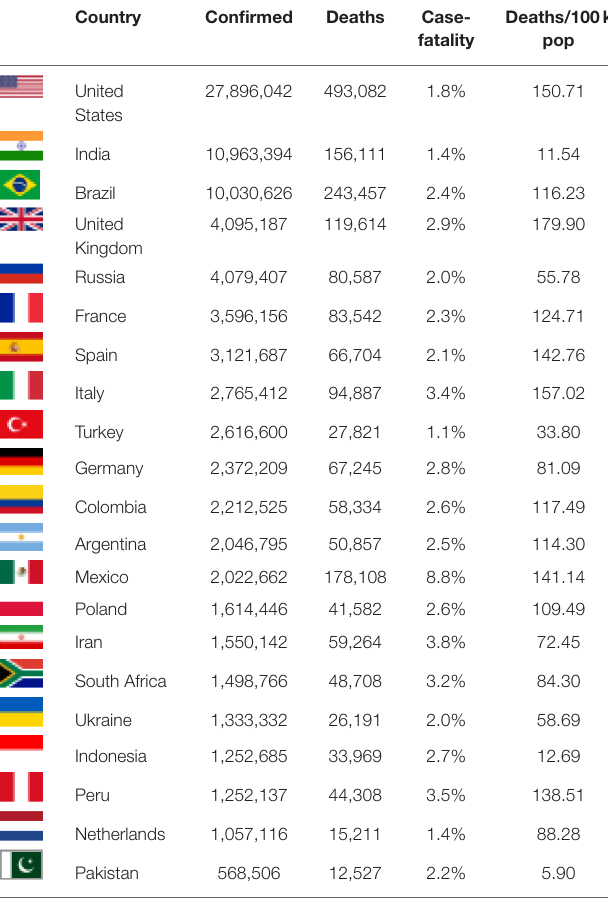
TABLE 2 | COVID-19: case mortality analysis worldwide (February 20, 2021).